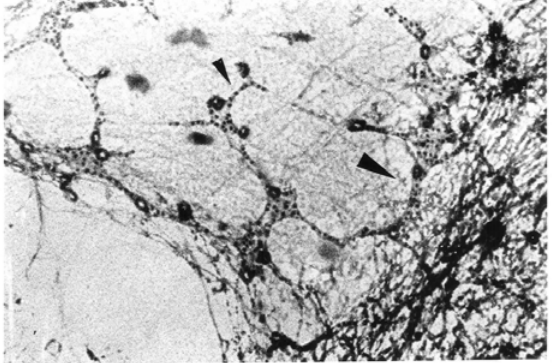
Fig. 3 – Dense networks are observed connecting neighboring pores (whitetrianglesinA-C).TheyareassociatedwithRNPparticles(small arrows in B) and with an spheroidal body (arrow in C). Altered chro- matinfibersarealsoobserved(arrowheadsinA-C).Spreadsofwhole4n nuclei; alcoholic uranyl acetate, Paladium shadowing. Bars = 125 nm (A and B), 140 nm (C).